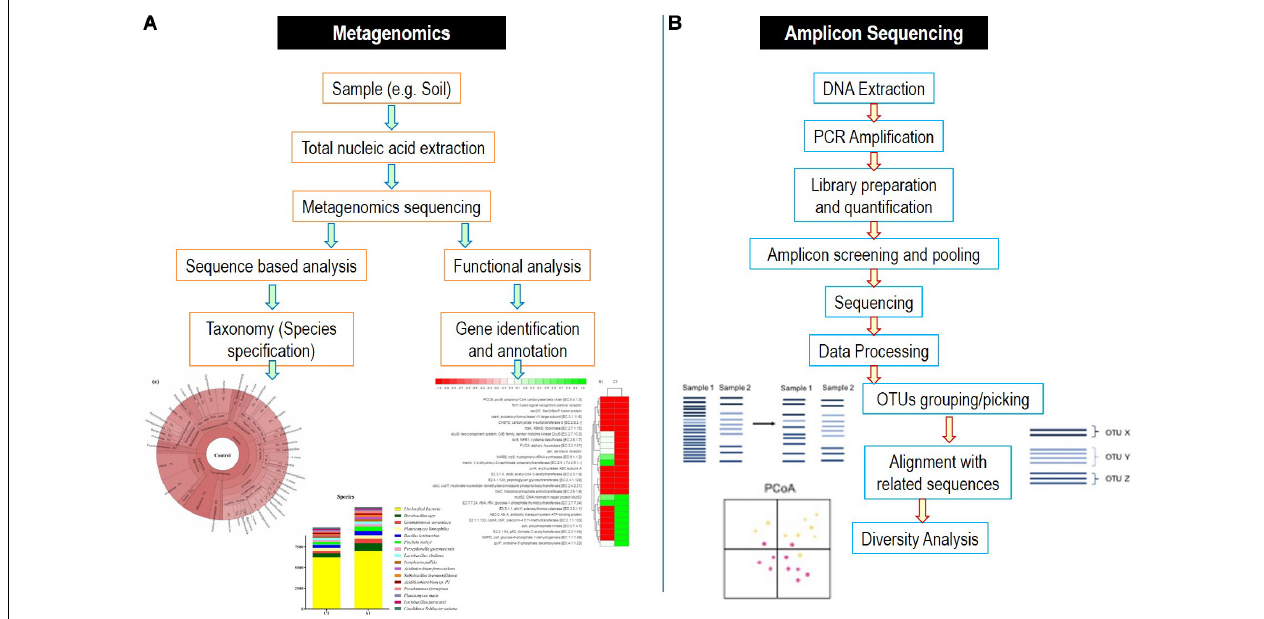
FIGURE 4 | Detailed flowchart-based methodology for (A) metagenomics and (B) amplicon sequencing methods.